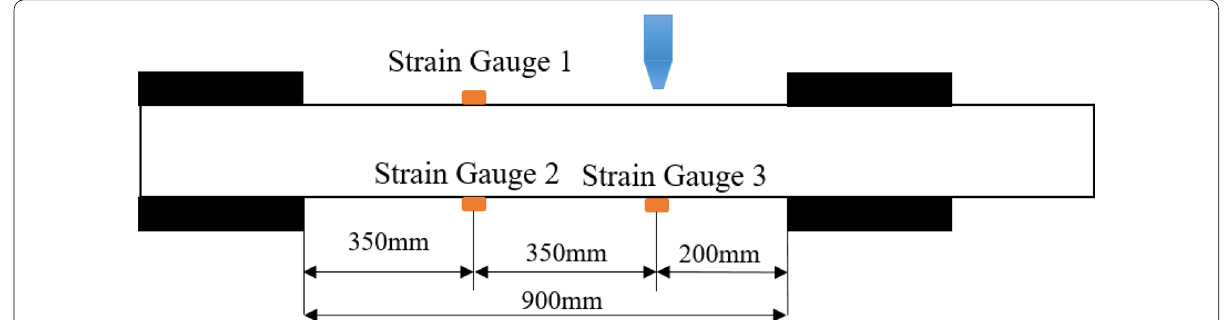
Fig. 16 Strain gauges positions and